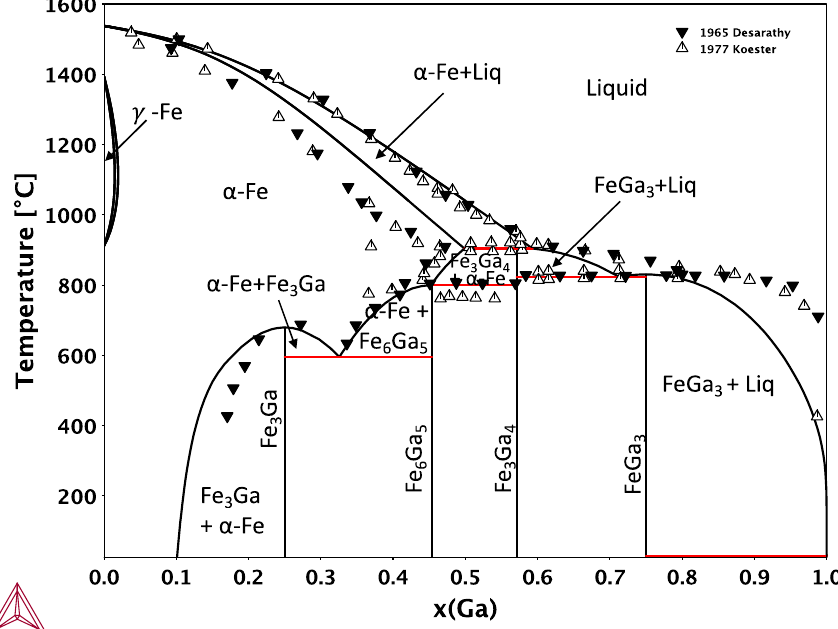
Figure 4. Calculated Fe-Ga phase diagram based on the present CALPHAD assessment and compared with experimental data [65–67].